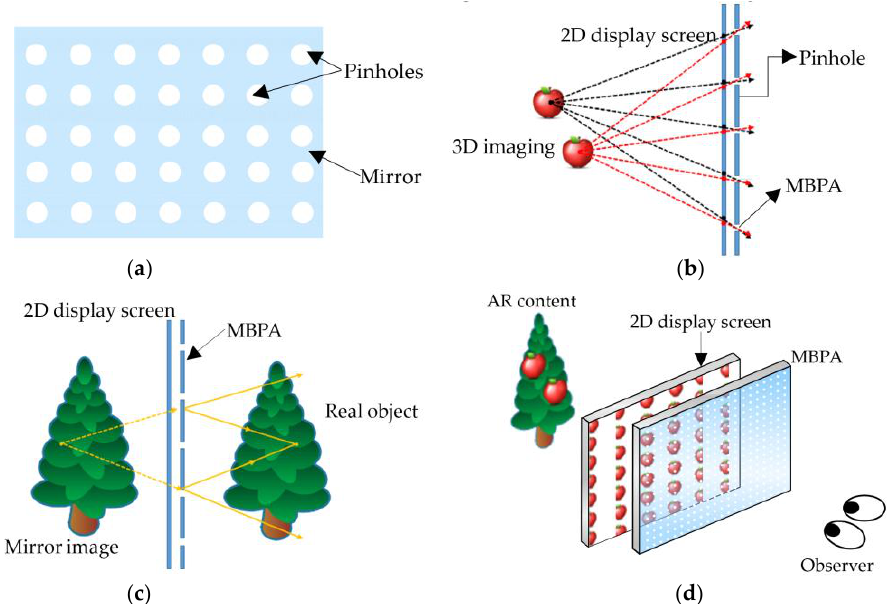
Figure 2. ( a ) The structure of the mirror-based pinhole array (MBPA), it consists of two parts: pinholes and mirror; ( b ) the 3D image formed by the lights of an elemental image array (EIA) transmitted through the pinholes of MBPA; ( c ) the mirror image formed by the reflected light of the real object reflected by the mirror area of the MBPA; and ( d ) the augmented reality (AR) display of the proposed reflective AR 3D display.